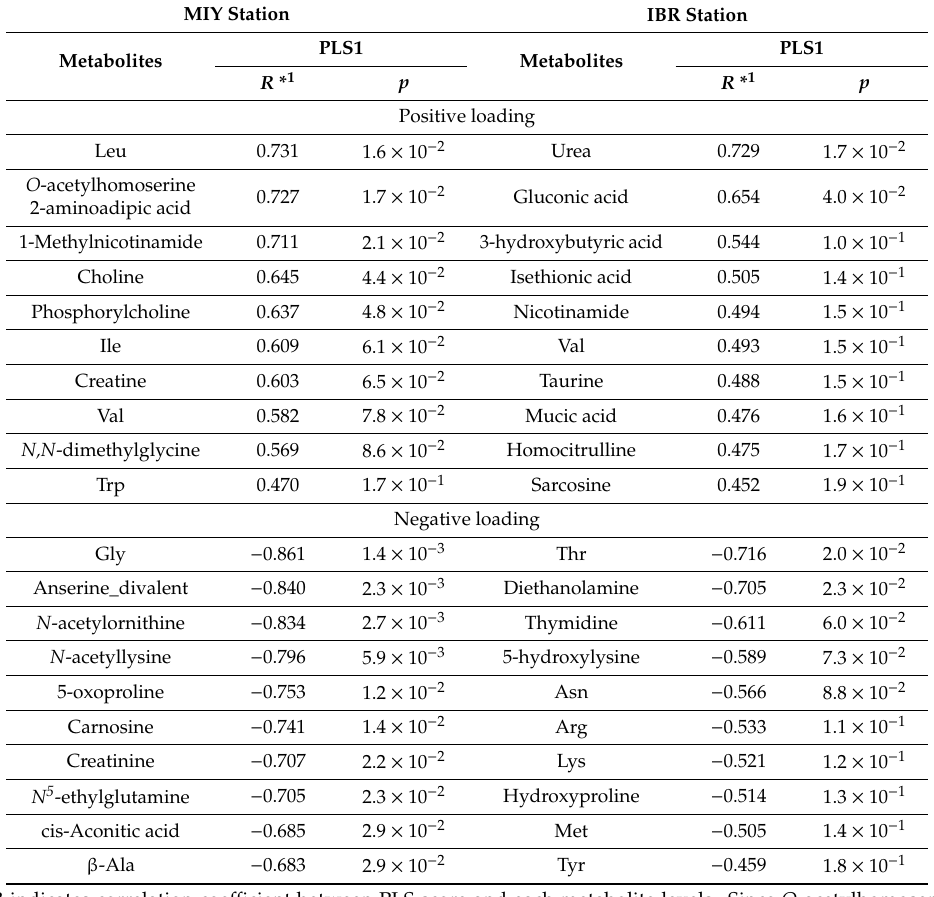
Table 2. Top 10 metabolites with positive and negative high loading values in partial least square at two